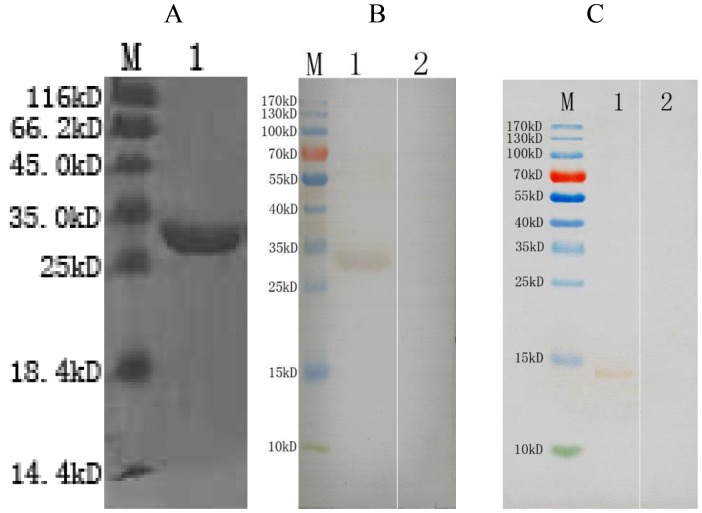
A: SDS-PAGE of recombinant protein purified. (Lane M) protein Mark (ordinate values in kDa); (Lane 1) MIC5 protein; B: Immunoblot for the recombinant EaMIC5. (Lane M) protein Mark (ordinate values in kDa); (Lane 1) Recombinant protein MIC5 probed by serum from chickens experimentally infected with E. acervulina as primary antibody; (Lane 2) Recombinant protein MIC5 probed by serum of normal chickens as primary antibody; C: Immunoblot for crude somatic extracts of E. acervulina sporozoites. (Lane M) protein Mark (ordinate values in kDa); (Lane 1) crude somatic extracts of E. acervulina sporozoites probed by serum from rat immunized by EaMIC5. (Lane 2) crude somatic extracts of E. acervulina sporozoites probed by serum of normal rat without immunizing as primary antibody.